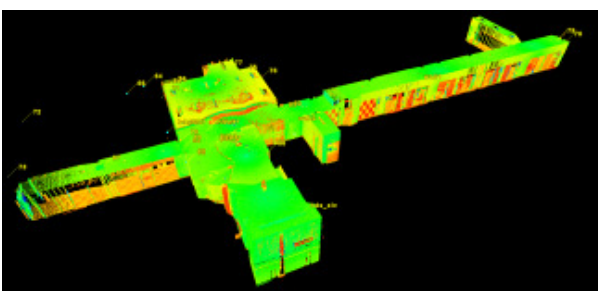
Figure 3: 3D point cloud acquired from a TLS system – here the inside of building (3 rd floor, colour indicates different intensity values).